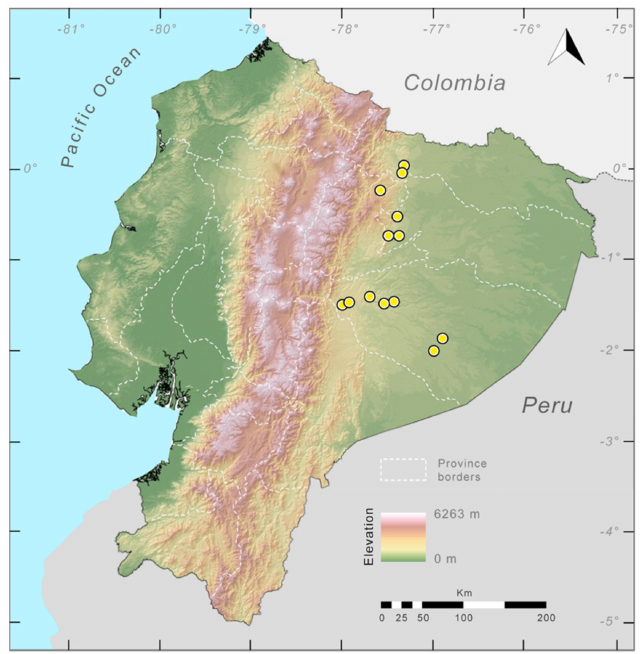
Figure 169. Distribution of Nymphargus mariae in Ecuador (yellow